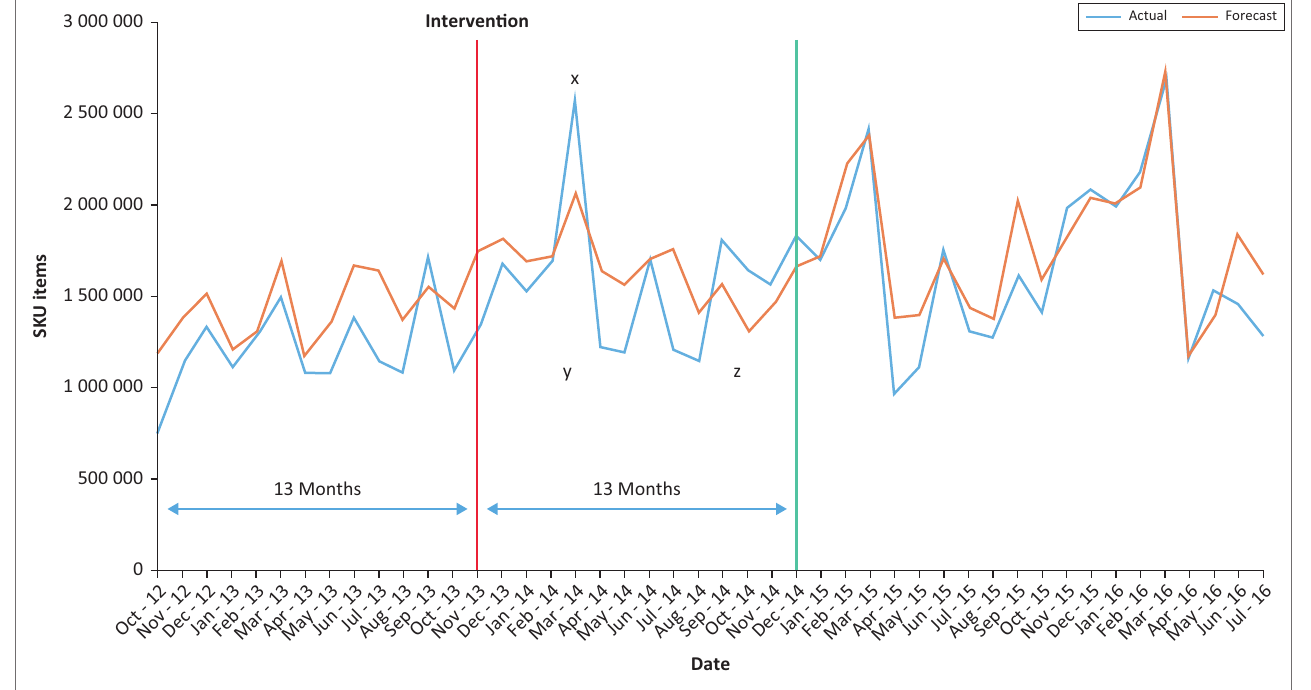
MAPE, mean absolute percentage error; SKUs, stock keeping